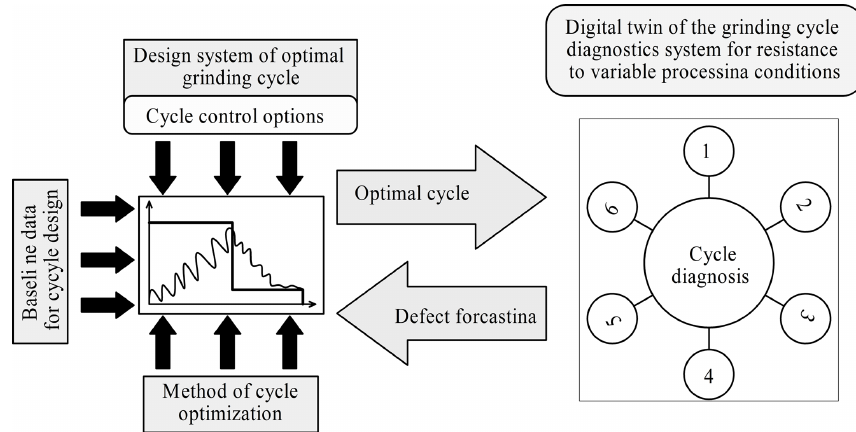
Figure 4. Scheme of interaction of the system for optimizing the MDP cycle with the digital twin of the cycle testing system: (1) defect prevention; (2) improving the reliability of the grinding cycle; (3) forecasting the accuracy and quality of processing; (4) formation of restrictions for variable conditions; (5) generation of variable grinding conditions; (6) cycle